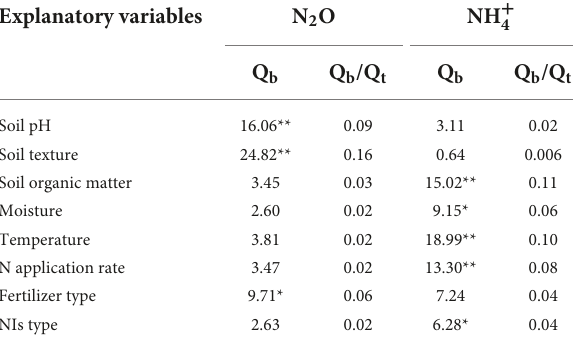
TABLE 1 Between-group heterogeneity (Q b ) illustrating the effects of NIs additions on N 2 O emission and NH + 4 concentration across categorical